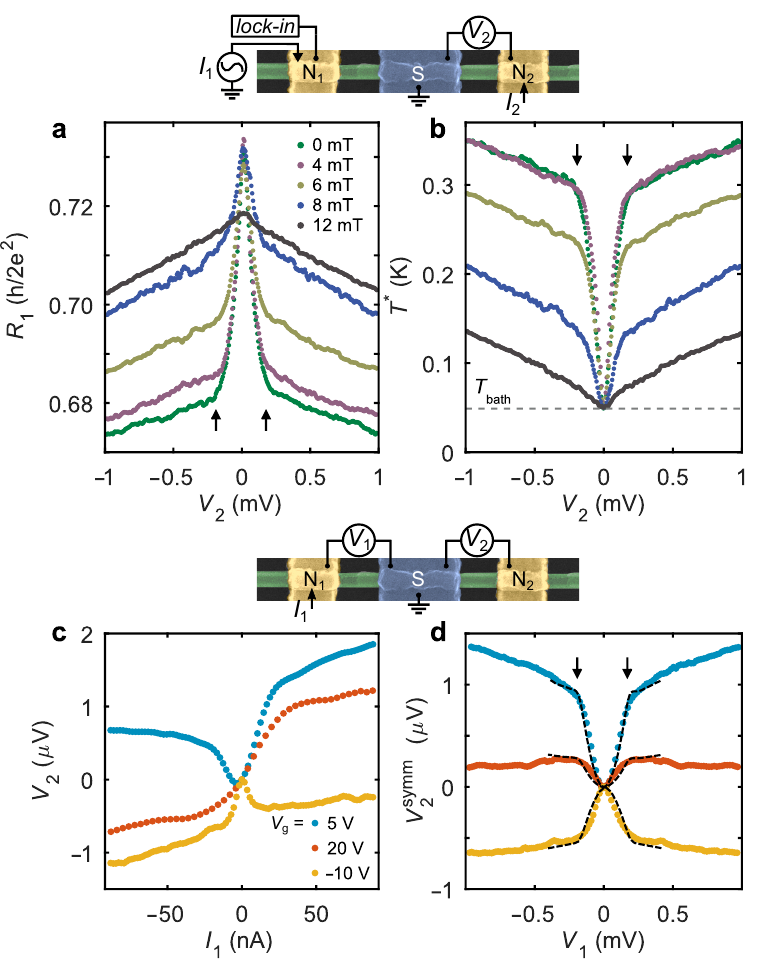
Figure 4. Resistive thermometry and non-local I - V s in device NSN-II. ( a ) Linear response resistance of the floating NS junction as a function of bias in the neighboring junction. ( b ) The same data converted to the effective temperature T ∗ . ( c ) The non-local I - V characteristics measured at three representative V g values. ( d ) Symmetric component of the non-local I - V s. The dashed lines are the calculated thermoelectric voltage values for different energy-independent Seebeck coefficients of S / T = 3.0 µ V/K 2 , 0.9 µ V/K 2 and − 3.6 µ V/K 2 (from top to bottom). Upper sketch: setup